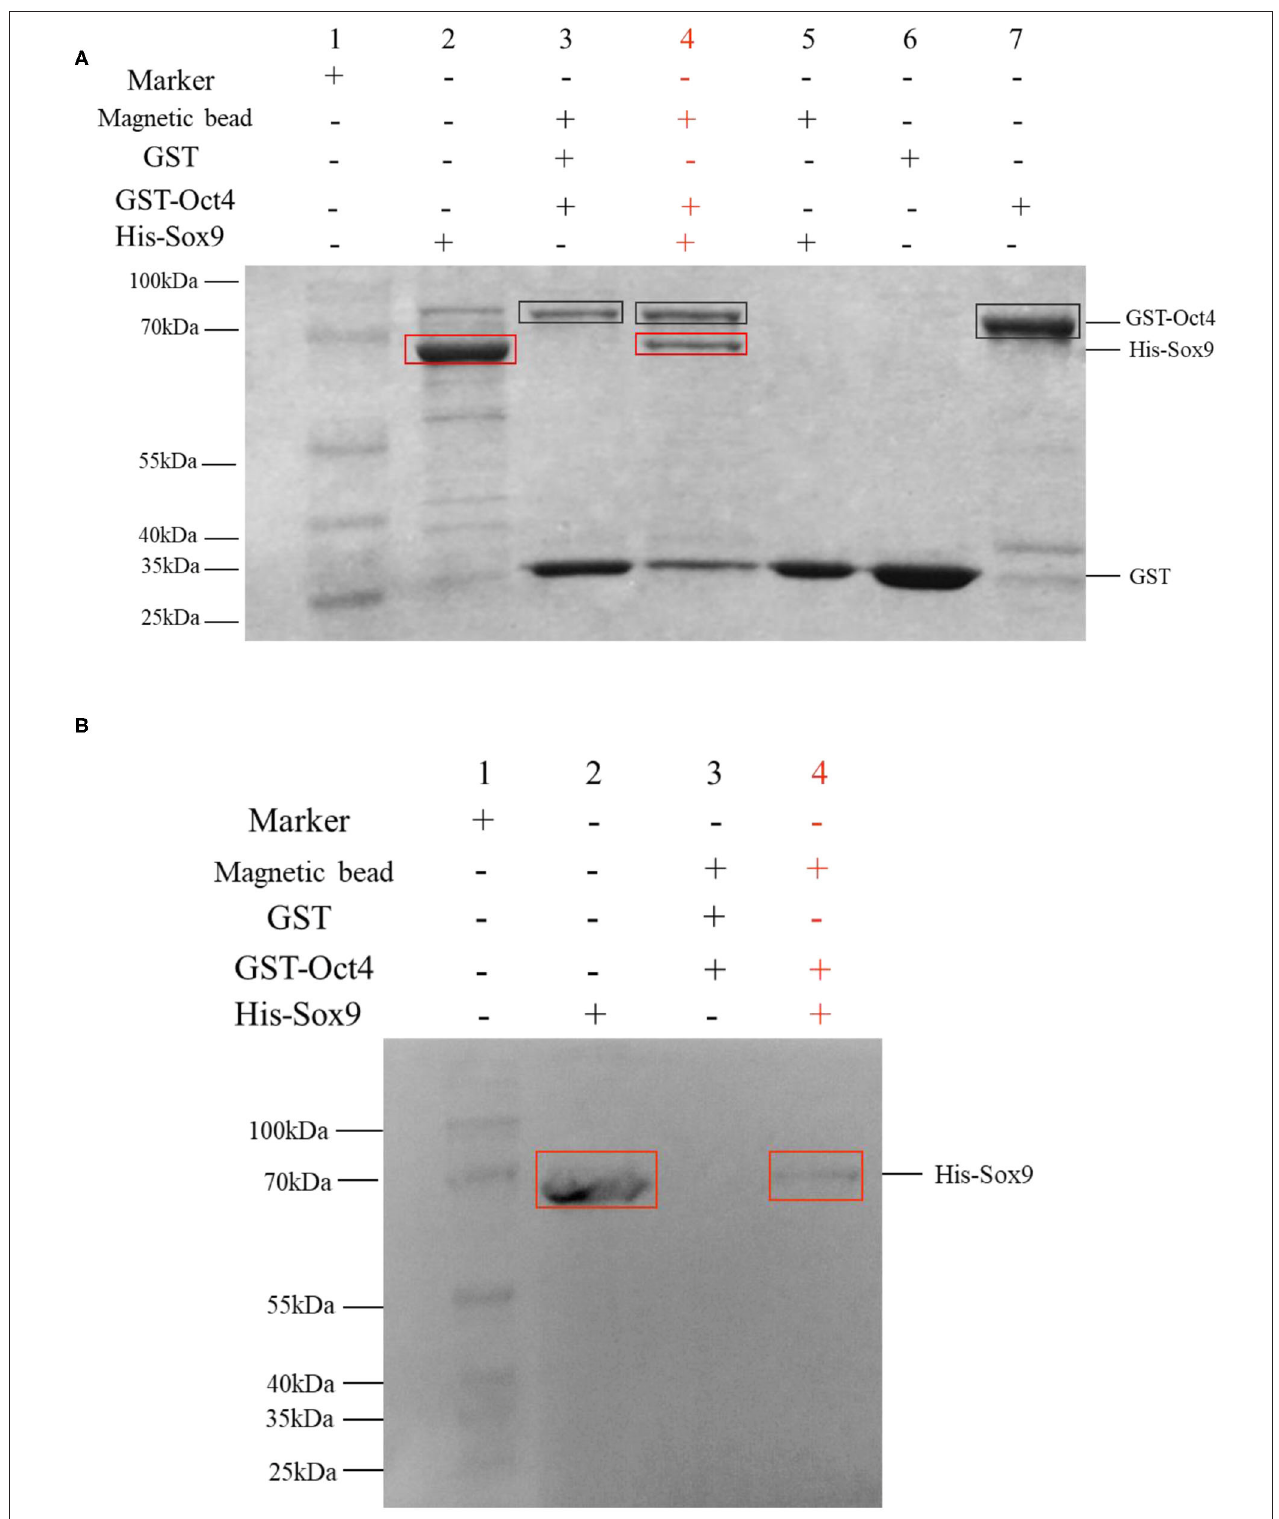
FIGURE 6 | GST pull-down assay to determine the interaction between Oct4 and Sox9. Recombinant His-Sox9 was incubated with recombinant GST-Oct4. (A) Western blotting was performed using antibodies against His tags. (B) SDS-PAGE detection. The experimental group was shown in red. In the figures, the GST-Oct4 protein was marked with a black box, and His-Sox9 protein was marked with a red box.